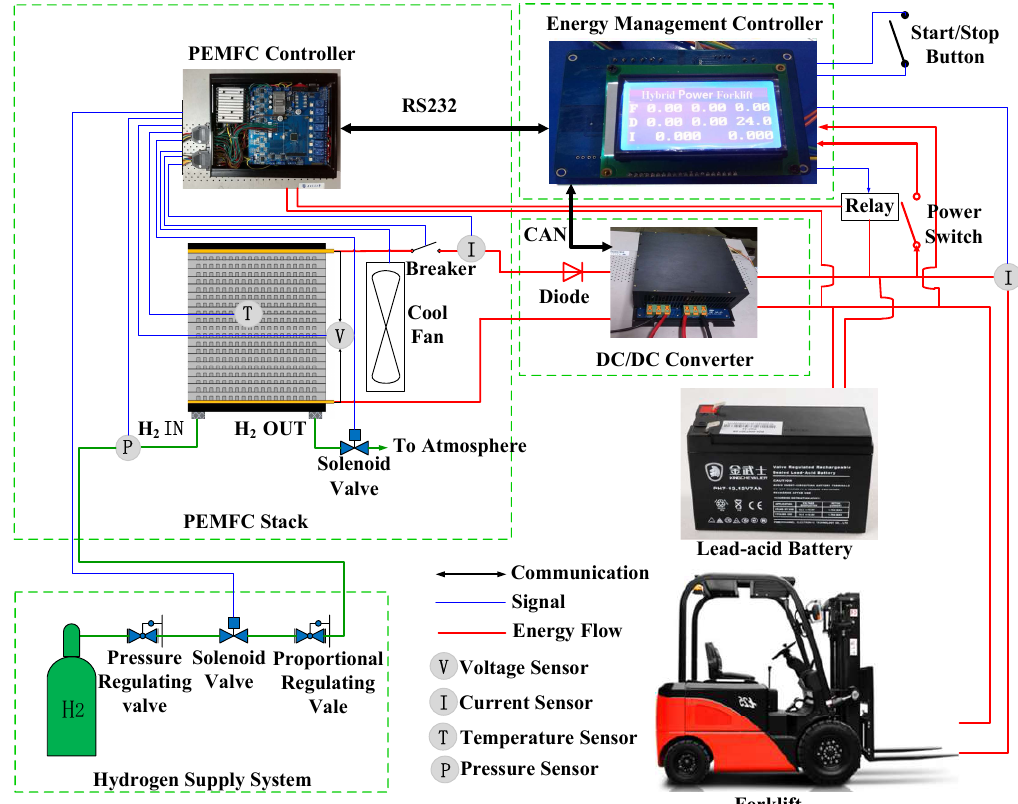
Figure 10. Fuel cell/battery hybrid forklift system structure. Table 2. Parameters of the hybrid system.